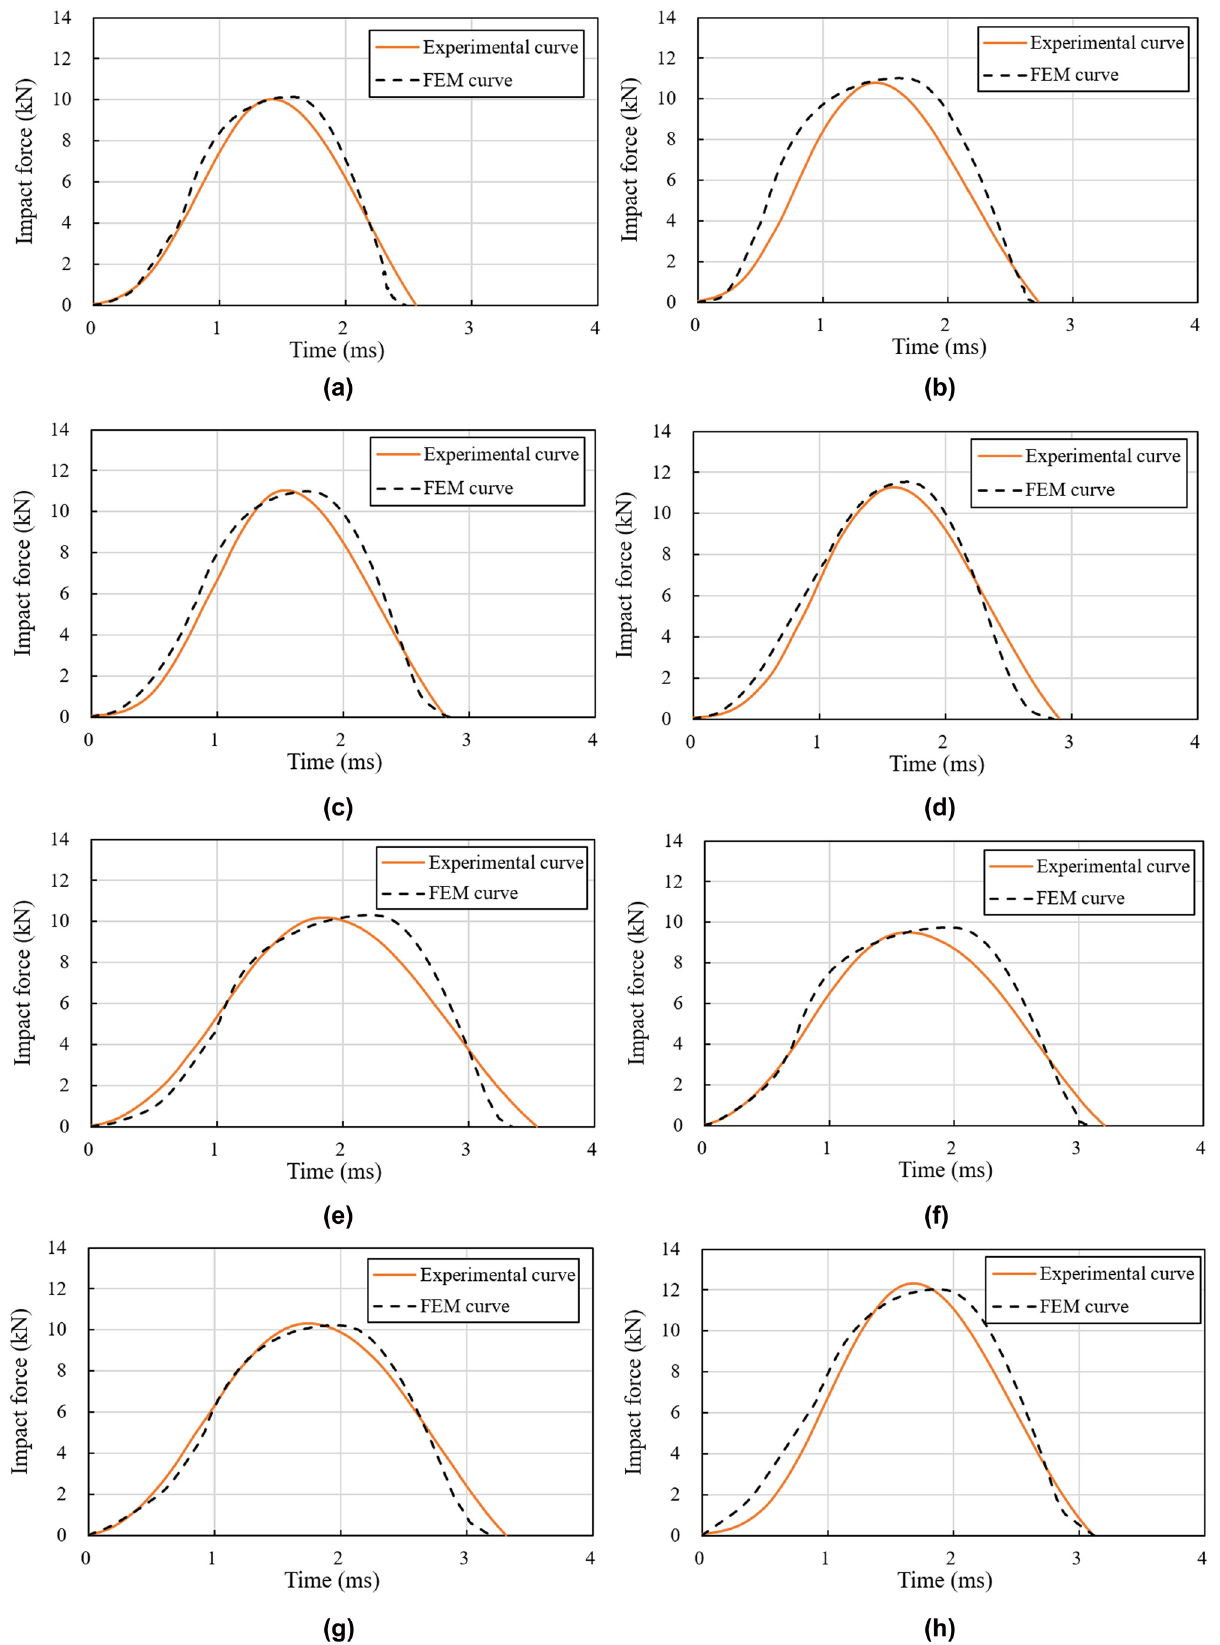
Figure 15: Comparison of numerical and experimental impact force histories for typical specimens: ( a ) F70M - I, ( b ) F70M - II, ( c ) F70MC0.6M - I, ( d ) F70MC1.2M - I, ( e ) F70C1.2 - II, ( f ) F70C0.6M - II, ( g ) F70C1.2M - II, and ( h ) F70MC1.2M -